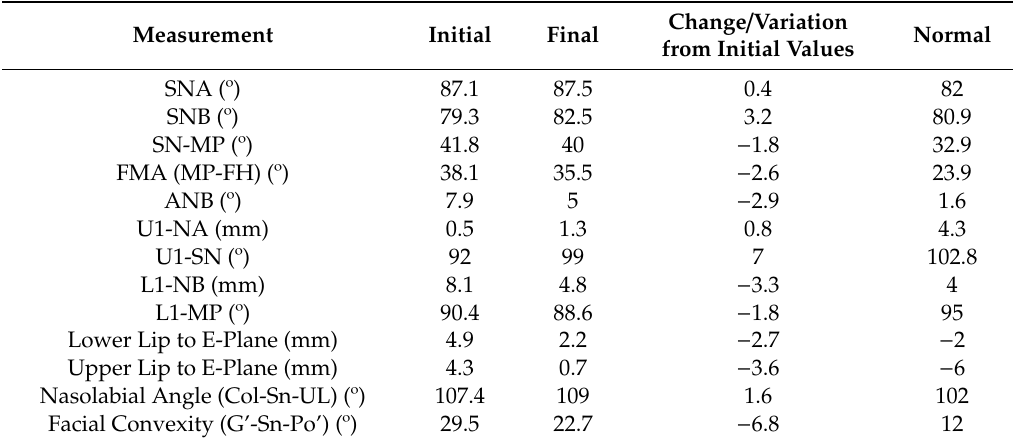
Table 1. Before-and-after treatment cephalometric analyses of case